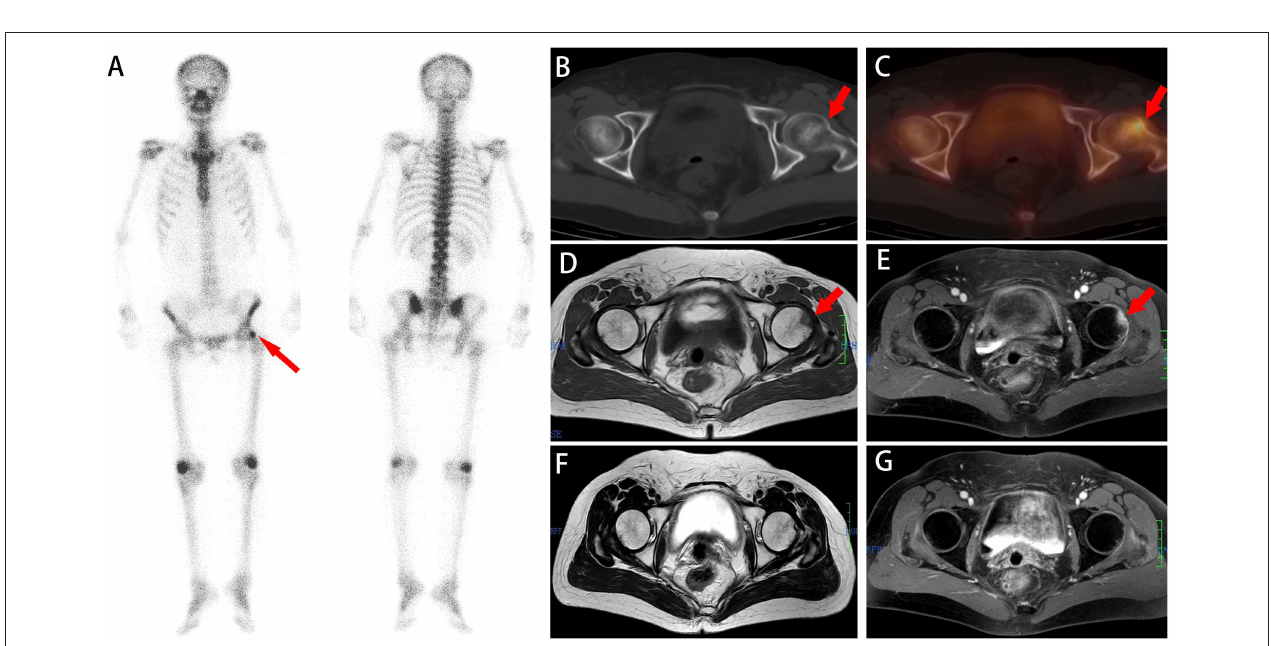
FIGURE 5 | A whole-body scan (A) revealed a focal area of high 99m Tc-MDP activity in the left femur (red arrow). No additional areas of abnormal 99m Tc-MDP uptake were identified in the remainder of the skeleton. Axial (B,C) CT and SPECT/ CT imaging showed focally increased 99m Tc-MDP uptake without density changes in the proximal part of the femur. Axial (D,E) MR images show high signal on T1WI and T2WI that disappeared 5 months later (F,G) . The diagnosis of IF was established based on a combined assessment of clinical and radiologic follow-up.